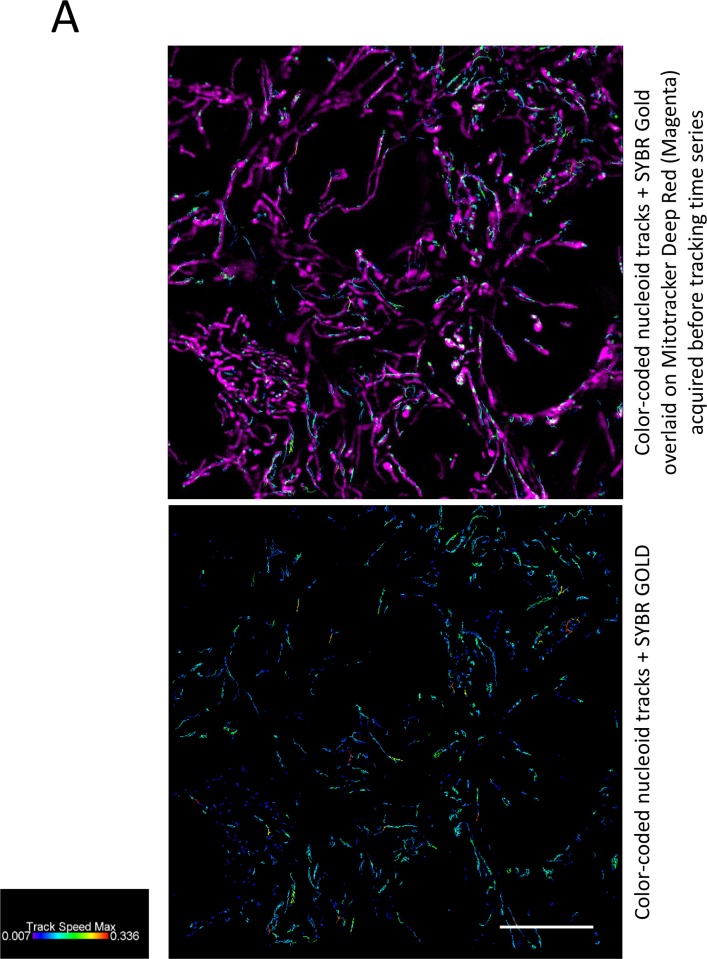
Quantification of mitochondrial nucleoids positions in live HeLa cells on SIM images.A. Representative optical slice of a z-stack of live cells labelled with SYBR Gold (green) and Mitotracker Deep Red (magenta). PS1 Elyra, SIM mode. Red dashed square on the top panels mark a region of interest which is shown on the bottom panels. Scale bar, 10 μm. Intensity profile for a linear ROI is shown on bottom zoomed panels. B. Intensity profile across image of a cell (single optical slice) described above. SYBR Gold signal, green line; Mitotracker Deep Red signal, magenta line. C. Histogram of distribution of distances to the closest neighbors for mitochondrial nucleoids in 3D SIM datasets spanning whole cell thickness.